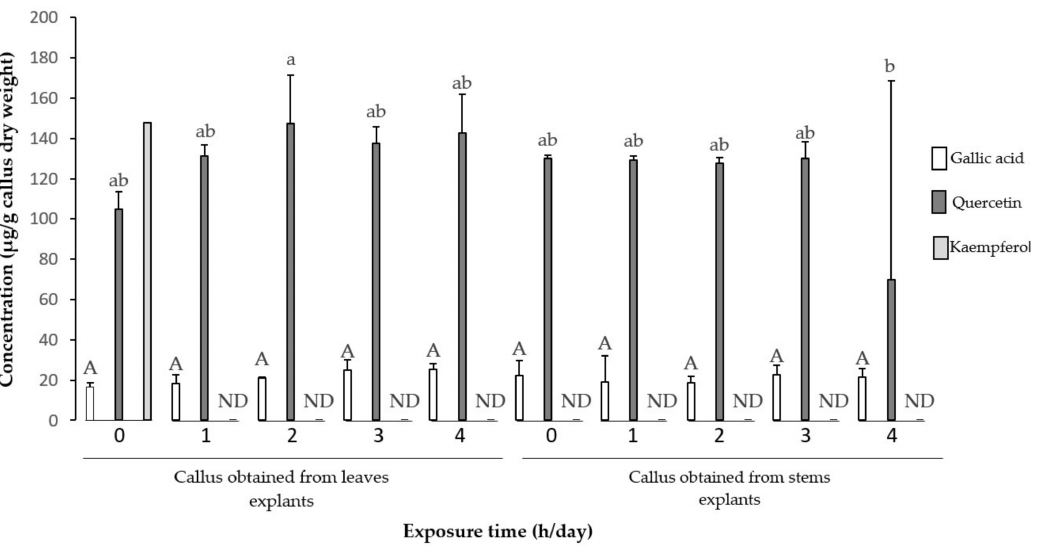
Figure 4. Effect of time of exposure to UV-B light on the concentration of gallic acid, quercetin and kaempferol in calluses with 2 weeks of exposure. Upper case letters indicate significance for gallic acid, lower case letters indicate significance for quercetin and numbers indicate significance for kaempferol with 1 being the highest significant level ( p ≤ 0.05). ND = not detected.